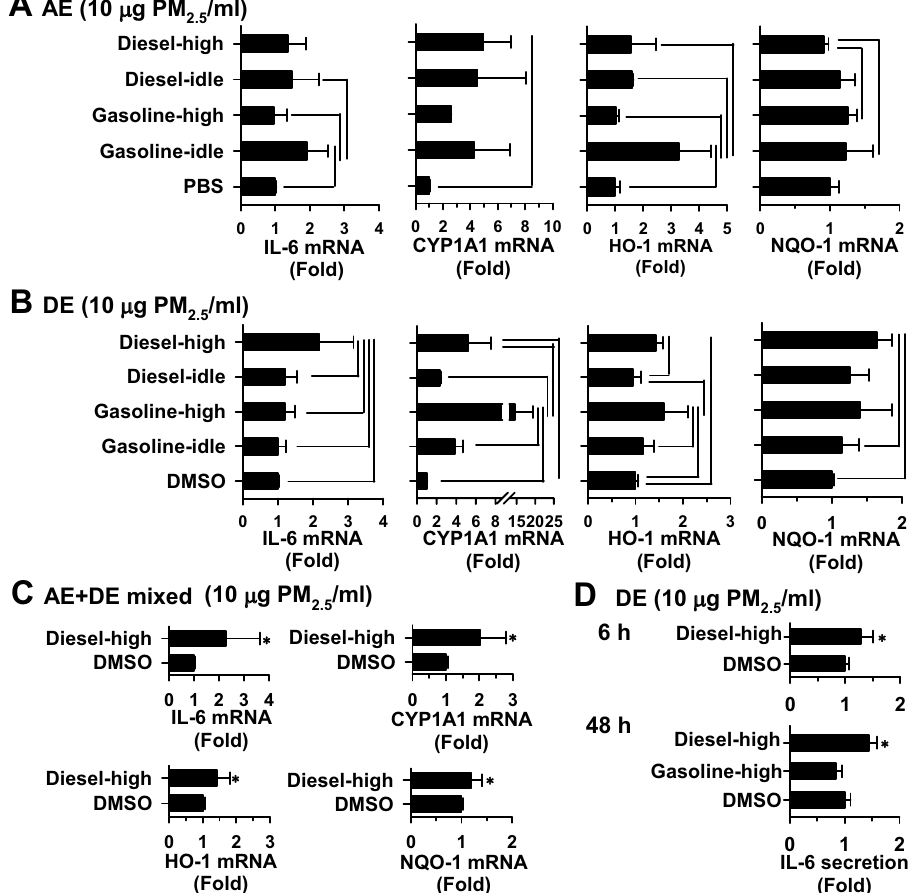
Figure 5. The biomarker transcript induction ( A – C ) and IL-6 secretion ( D ) by the extracts of PM 2.5 particulates of fuel exhausts from engines under idling operation or high speed in A549 cells. In panels ( B )– ( D ), cells were exposed to the aqueous extract (AE) and dichloromethane extract (DE) of PM 2.5 particulates at a concentration as indicated for 48 h. After exposure, the mRNA levels of biomarkers were analyzed using real-time PCR analysis as described in the Methods. In panel ( E ), cells were exposed to the DE of diesel- high emission for 6 and 48 h as indicated. Data represent the means ± SD of three different experiments with duplicate determinations in each experiment. The lines between pairs of bars indicate that there are significant differences ( p < 0.05) between two exposures in the one-way-ANOVA analysis with post-hoc Tukey’s test for multiple comparison. * p < 0.05 (compared to the control using Student’s t